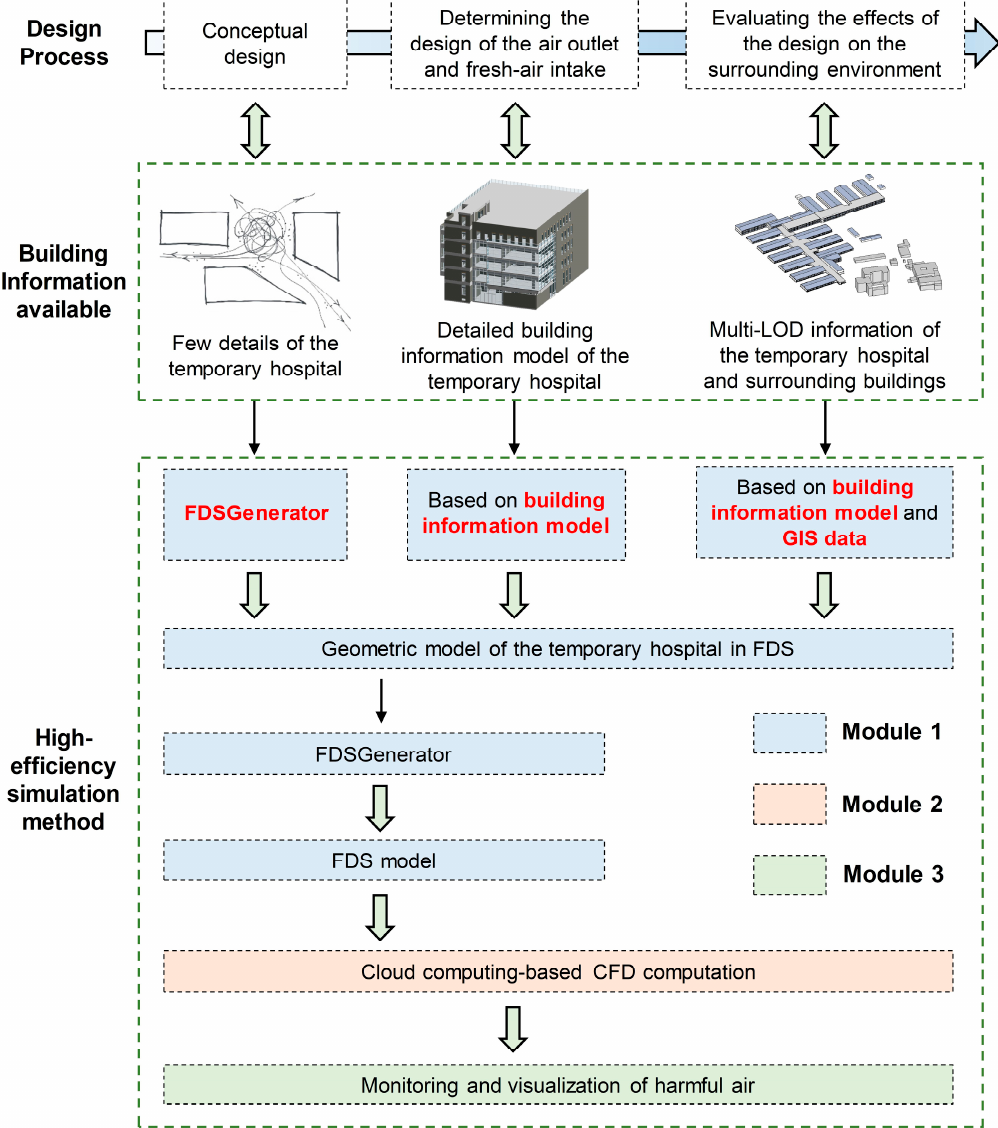
Figure 1. Proposed high-efficiency simulation framework based on FDS for analyzing the impact of exhaust air from the temporary hospital.